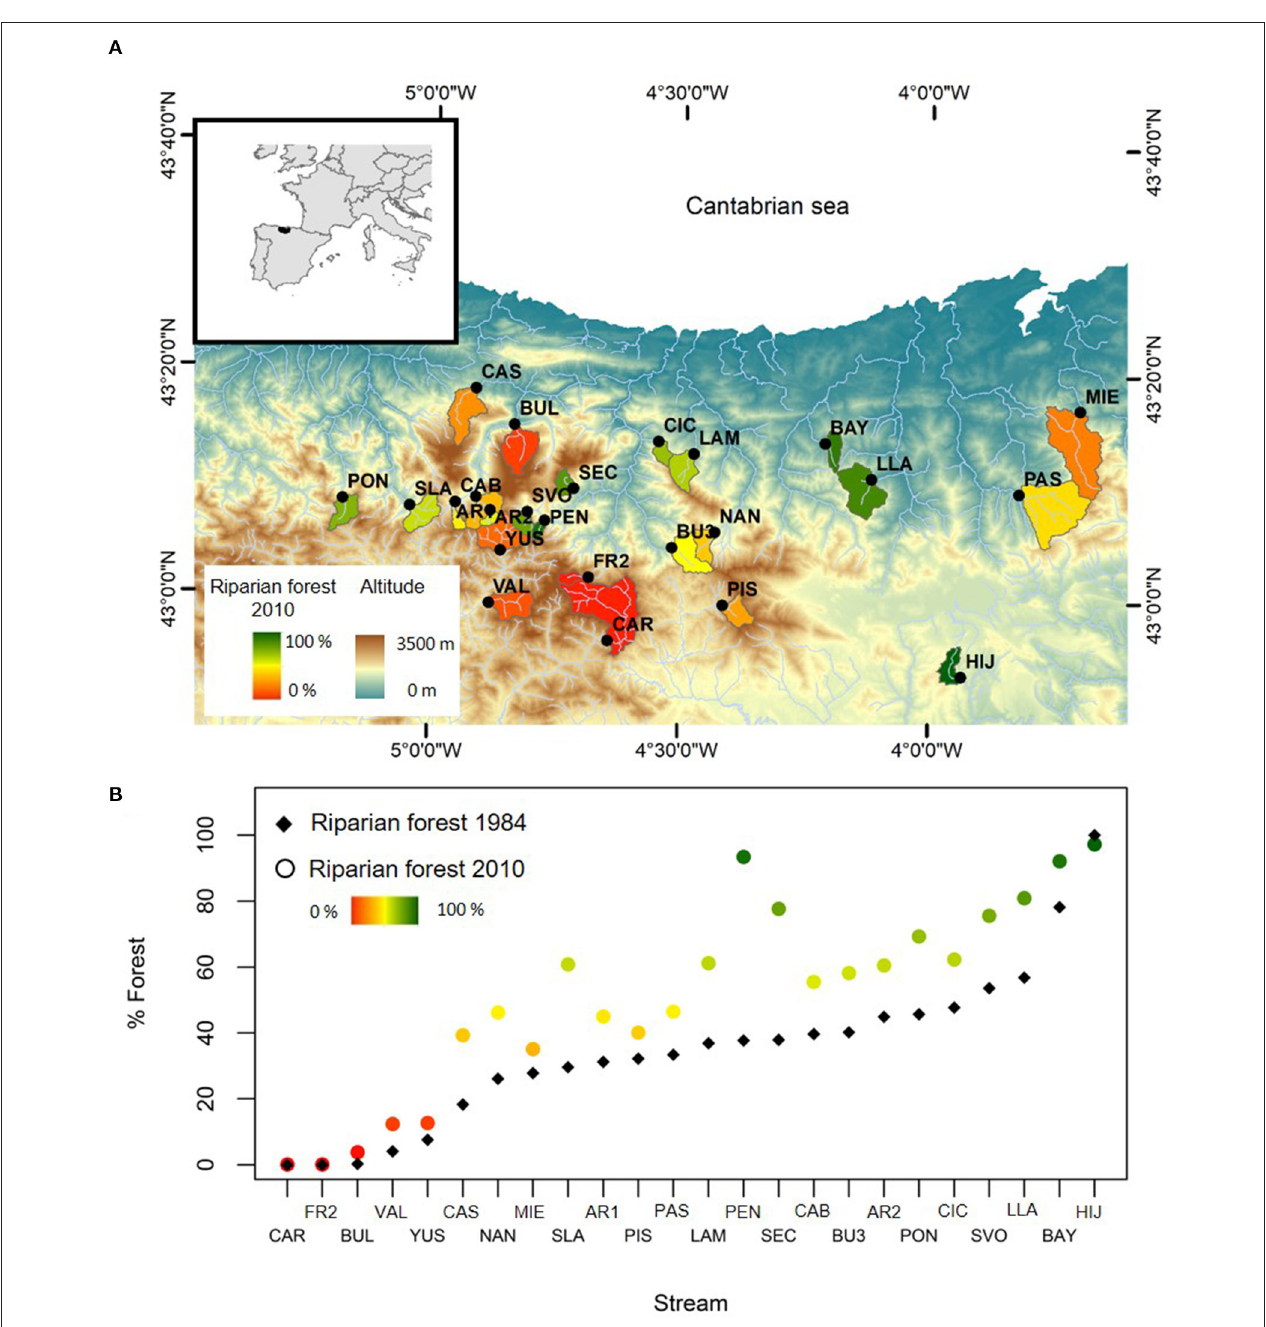
FIGURE 1 | (A) Map of the study area showing the location of the 24 streams and their catchments in the Cantabrian Mountains, Northern Spain. Catchments are colored according to current riparian forest cover. (B) Variation of riparian forest cover between 1984 (black diamonds) and 2009 (circles colored according to current riparian forest cover) in each of the studied streams. Stream codes correspond with Supplementary Material 1 .